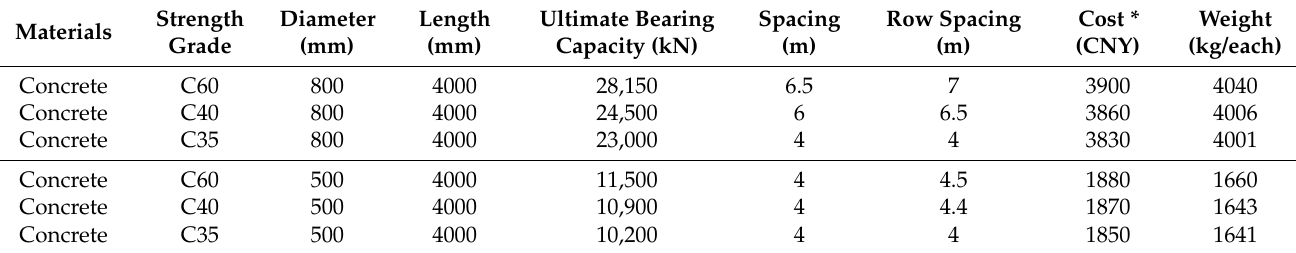
Table 4. The parameters of different types of pillars.